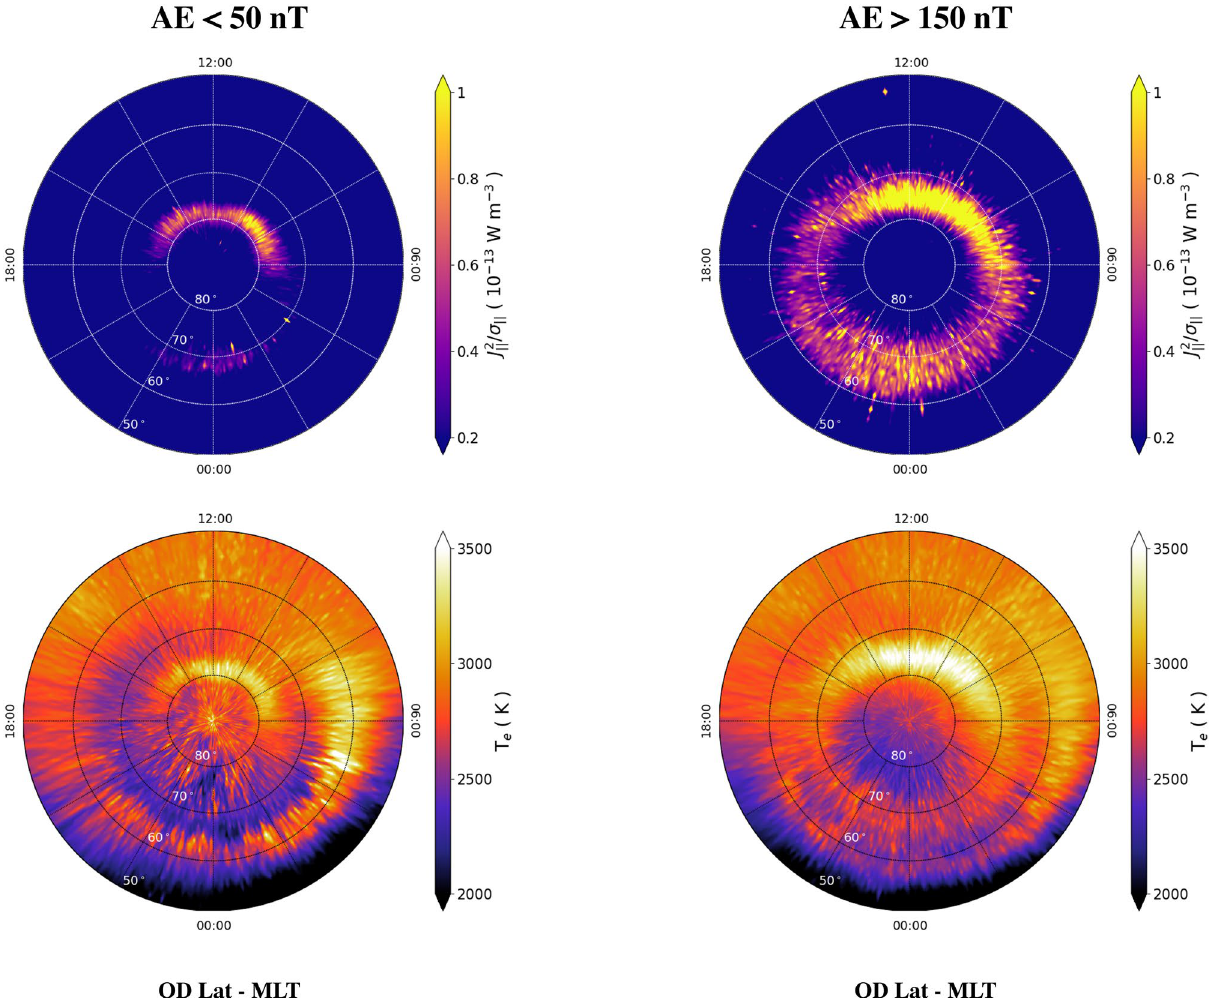
Figure 2. Maps in QD latitude vs MLT coordinates of dissipated power density, J 2 || /σ || (top row), and electron temperature, T e (bottom row) in the Northern hemisphere during quiet (left column) and disturbed (right column) conditions. The values of J 2 || /σ || are saturated below 0.2 × 10 − 13 W m − 3 and above 1.0 × 10 − 13 W m − 3 . The values of T e are saturated below 2000 K and above 3500